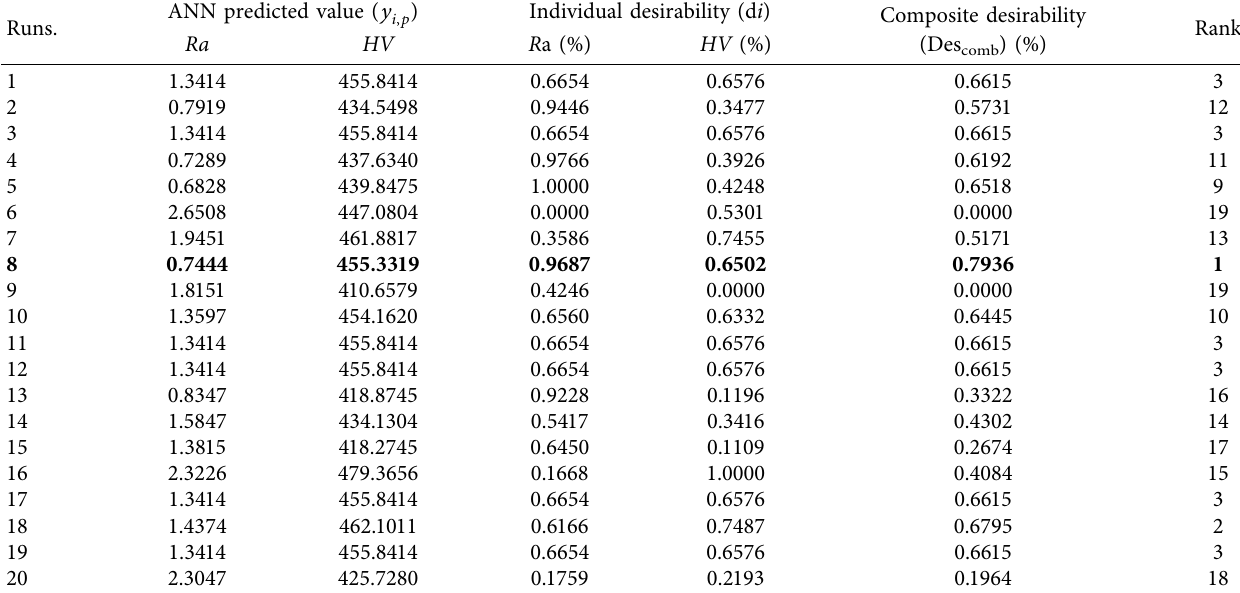
Table 10: Expectation assessment for Ra and HV .